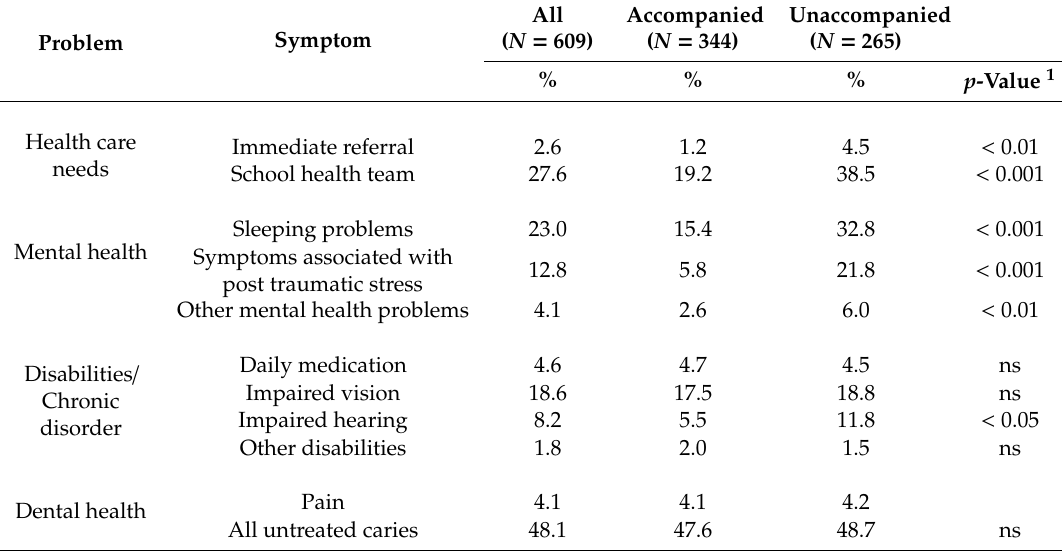
Table 2. Health problems in the population of school-age